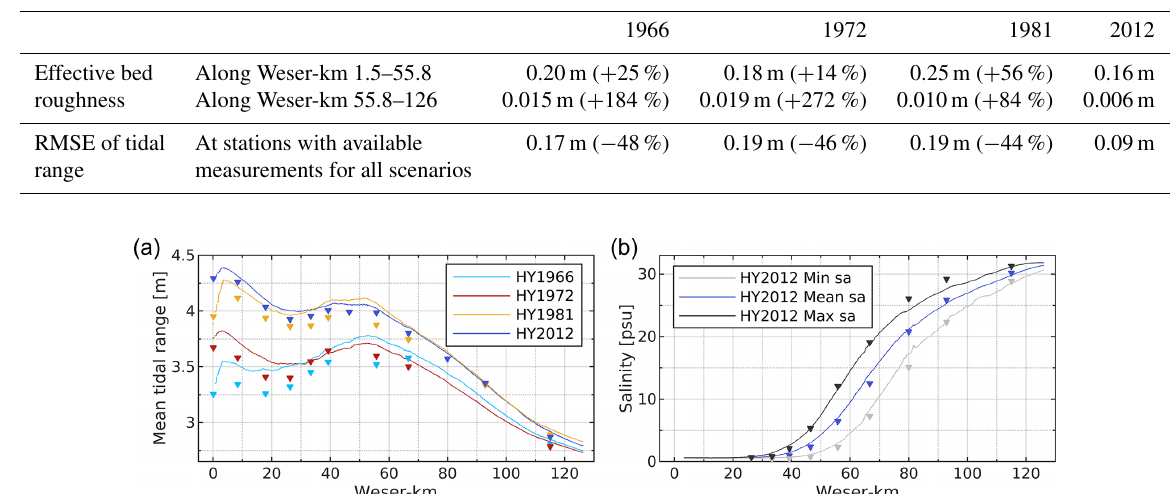
Table 2. Effective bed roughness along the navigation channel of the Weser estuary (see Fig. 1) and RMSE of the tidal range for the individually calibrated models. For 1966, 1972, and 1981, results are compared with respective calculations with roughness settings of 2012 (before individual recalibration).